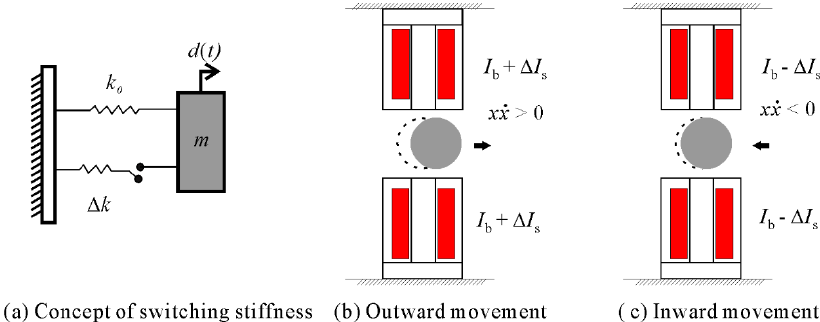
Figure 2. Switching stiffness in magnetic suspension system: ( a ) switching stiffness in sdof system; ( b , c ) currents in electromagnets for different conditions.